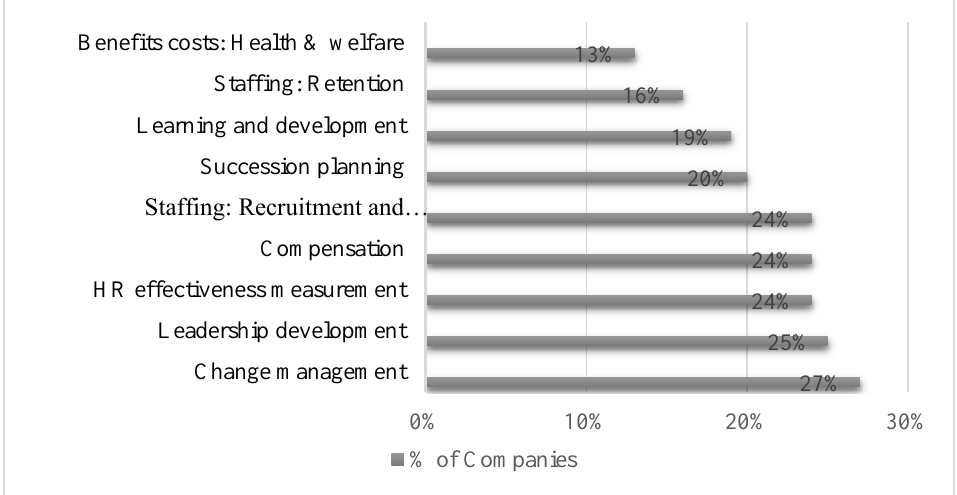
Figure 3. The Top Ten Most Important Issues in Management According to the Villanova University Ranking Source: The American Society for Training and Development (2005)